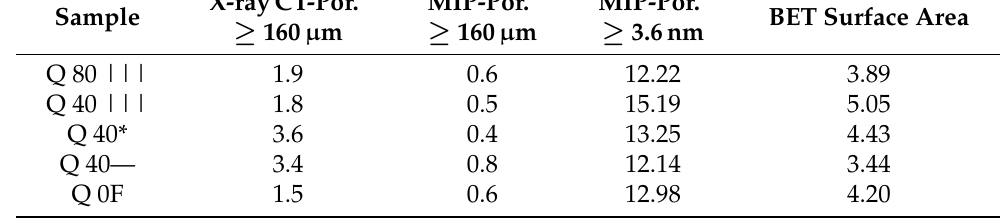
Table 2. Porosities determined by X-ray CT and MIP in vol.% and BET surface area in m 2 /g. Sample